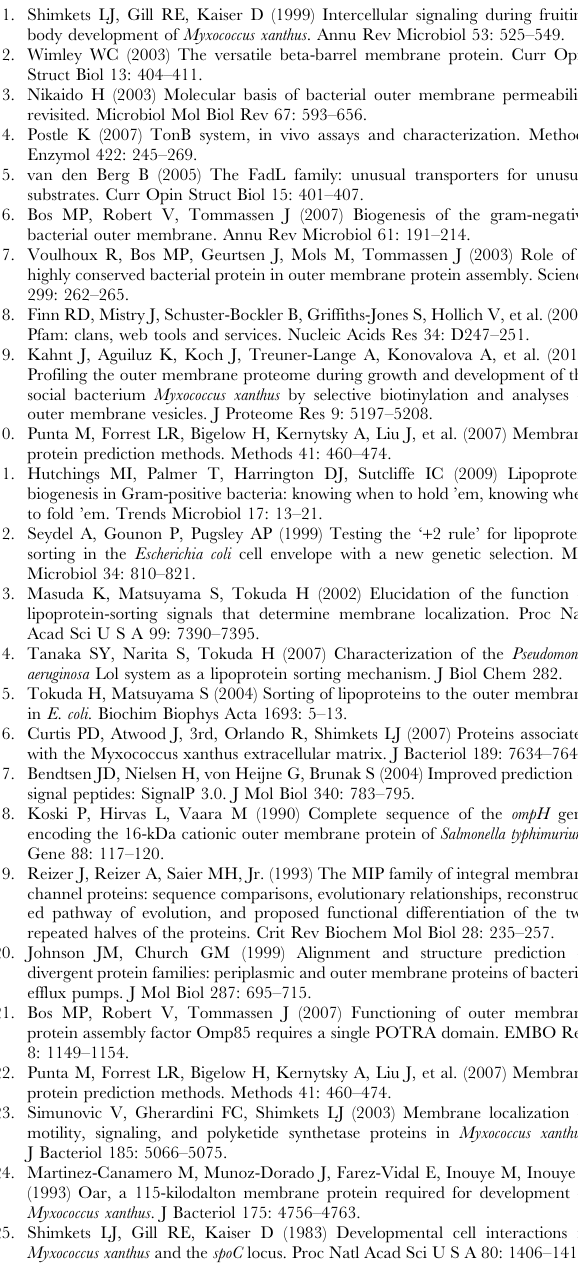
Table S2 List of non-outer membrane integral proteins identified by